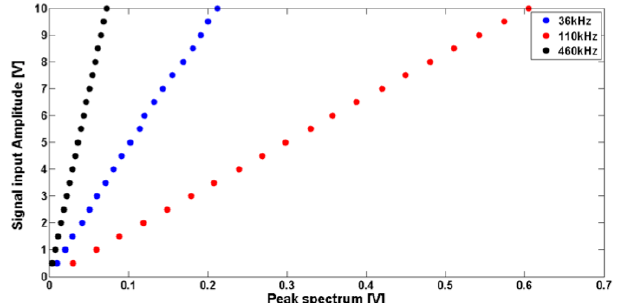
Figure 2. Multisensor bedload monitoring platform: static characteristics.